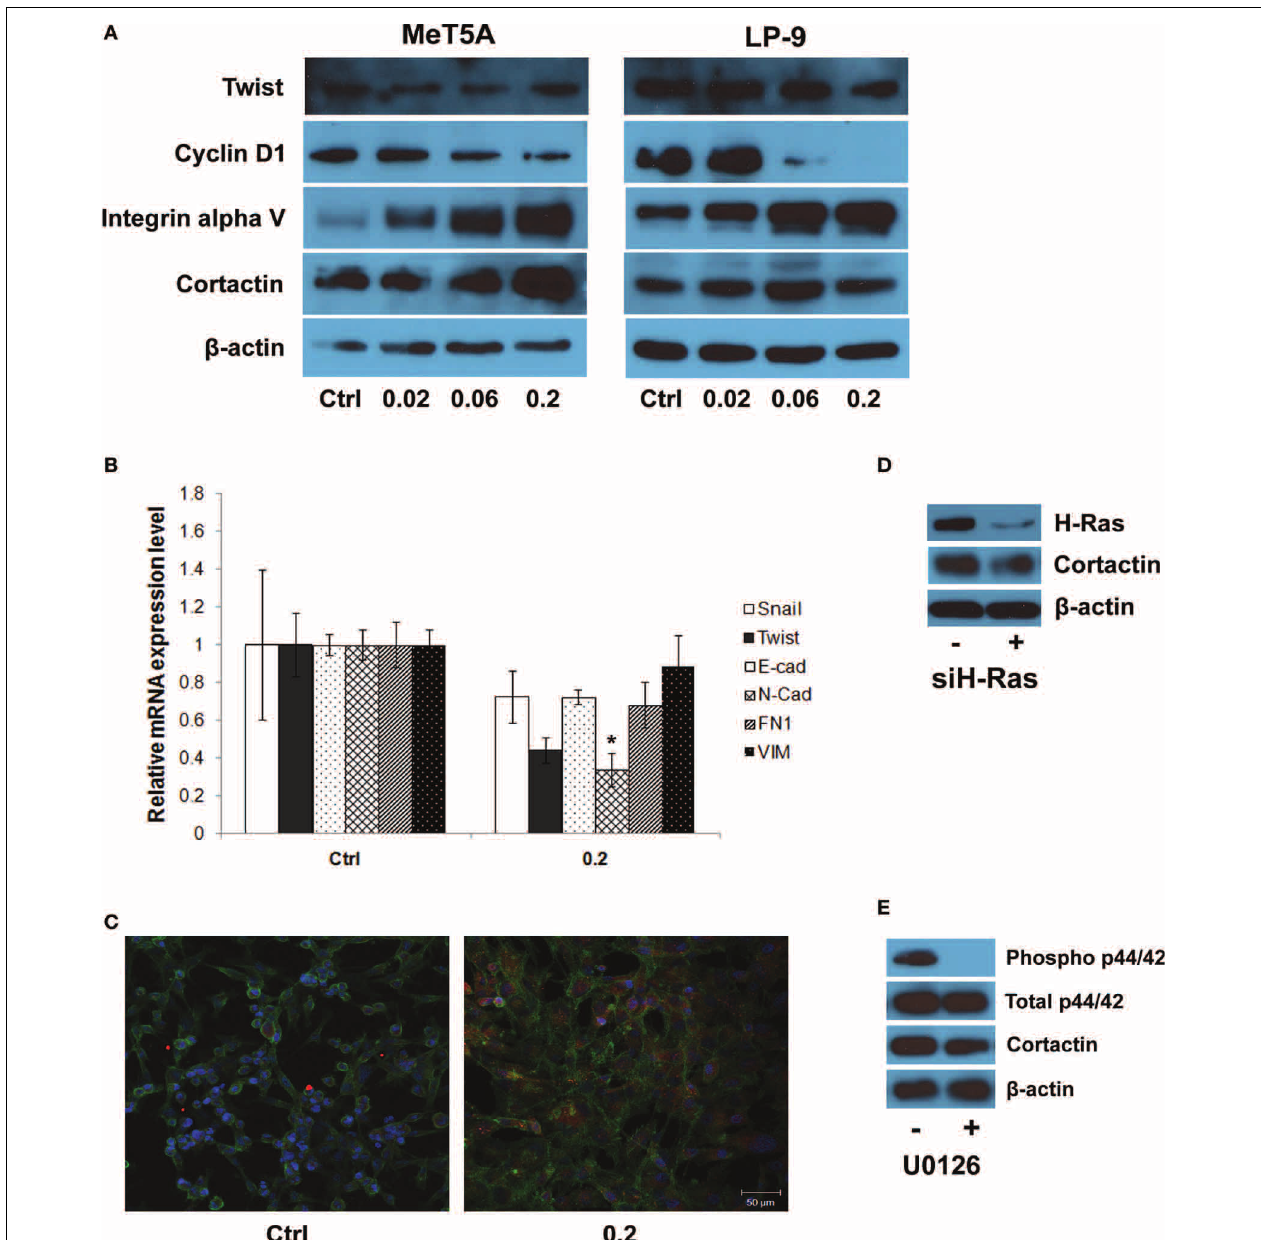
Immunofluorescence staining showed a substantial increase in cortactin protein expression in SWCNT (0.2 μ g/cm 2 )-exposed MeT-5A cells compared to control cells (C) . Down-regulation of H-Ras by siH-Ras (D) and inactivation of ERK by U0126 (E) lowered the expression of cortactin in SWCNT-exposed MeT-5A cells. ∗ Significantly difference from no treatment control with P < 0 . 05 ( n =